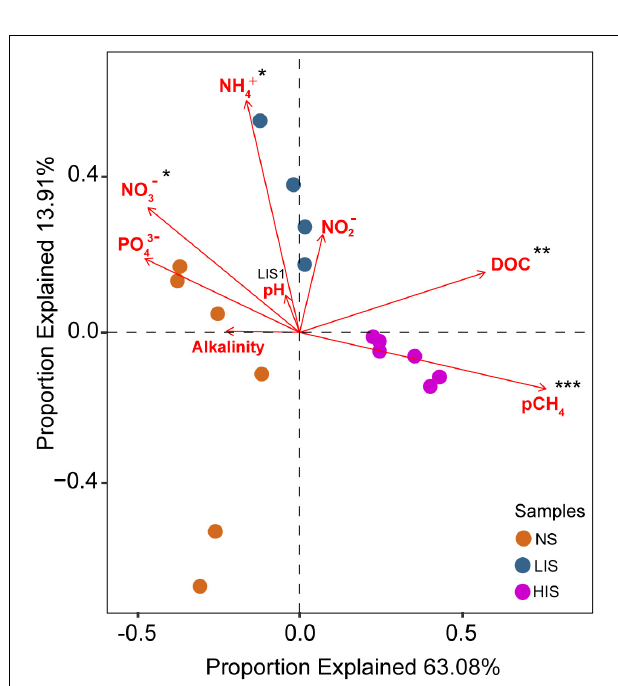
FIGURE 5 | Redundancy analysis (RDA) correlating several environmental variables to bacterial communities. Circles represent the bacterial community of a given sample and red arrows indicate individual environmental parameters. The concentrations of methane (CH 4 ) used for this analysis were 0.27, 99.4, and 2,207.9 µ M at the NS, LIS, and HIS sites, respectively. Significance levels (marked by asterisks) were evaluated based on the Monte Carlo permutation test. *** p < 0.001; ** p < 0.01; * p <